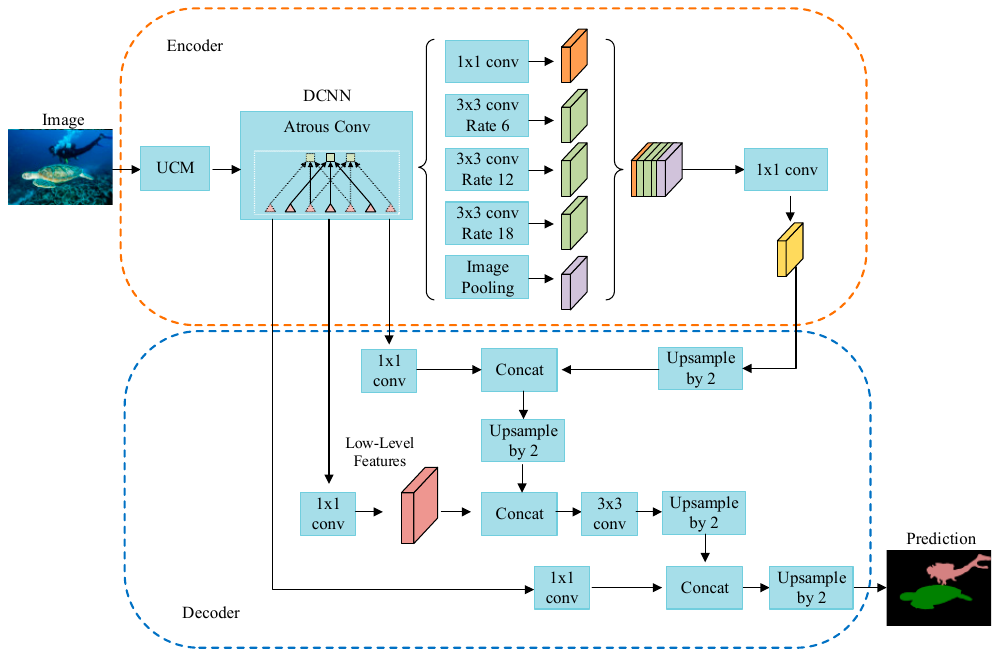
Figure 1. Structure of underwater image semantic segmentation network.